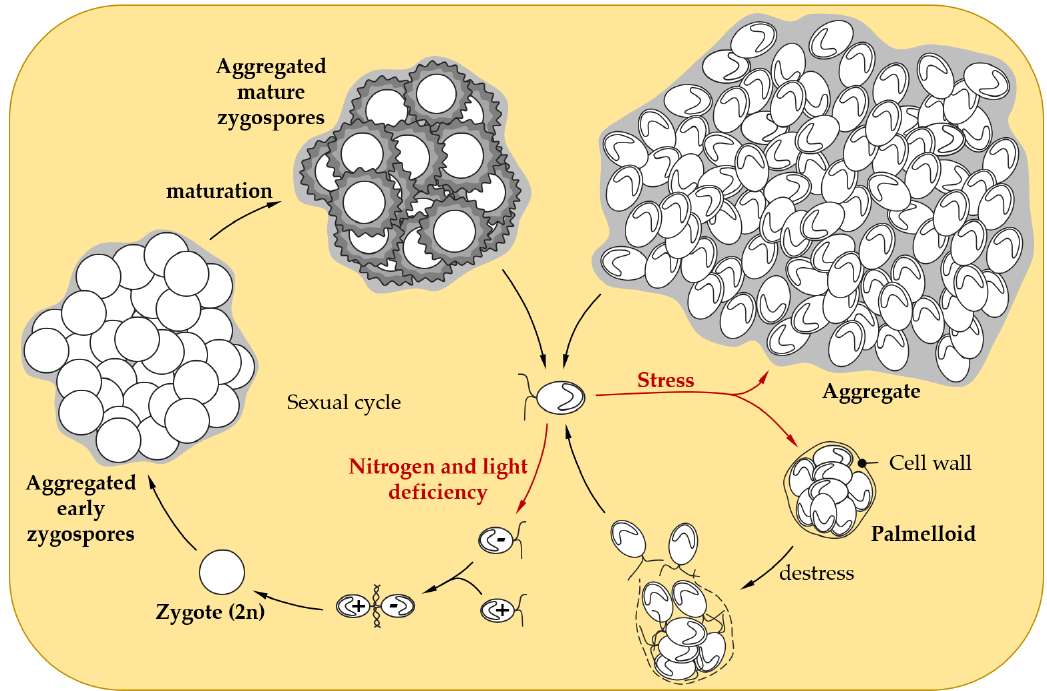
Figure 2. Social behavior in response to stress in Chlamydomonas . When facing adverse conditions, Chlamydomonas vegetative cells can form palmelloids, a cluster of 4 to 16 cells surrounded by a cell wall resulting from the division of a single cell. As soon as the environmental conditions improve, the outer cell wall is hatched, to allow the liberation of daughter cells [55]. When confronted with harsher stress conditions, Chlamydomonas cells are able to form larger multicellular structures called aggregates that might confer stress tolerance [60,61]. Under conditions of non-optimal growth (e.g., nitrogen or light limitation), Chlamydomonas can induce gamete differentiation to enable sexual reproduction, which leads to zygote formation after the mating of gametes. Maturation of the zygospore confers resistance to environmental stresses, such as desiccation [64]. In liquid cultures, early and mature zygospores can form aggregates, that could further enhance resistance to stress [65–67].